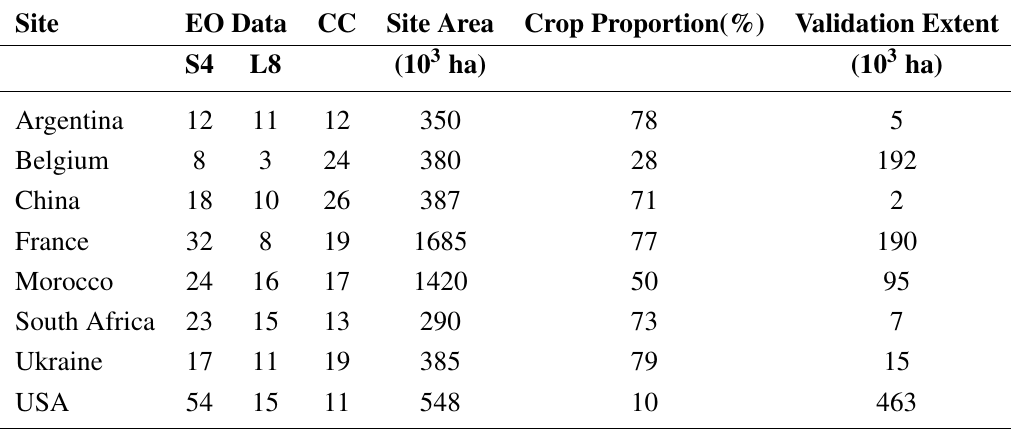
Table 3. Data availability for each site. Source of EO dataset (S4: Spot4; L8: Landsat-8). CC: mean cloud cover over the complete time series (%). Site area in hectares. Proportion of cropland represented in the validation dataset. Total extent of the validation